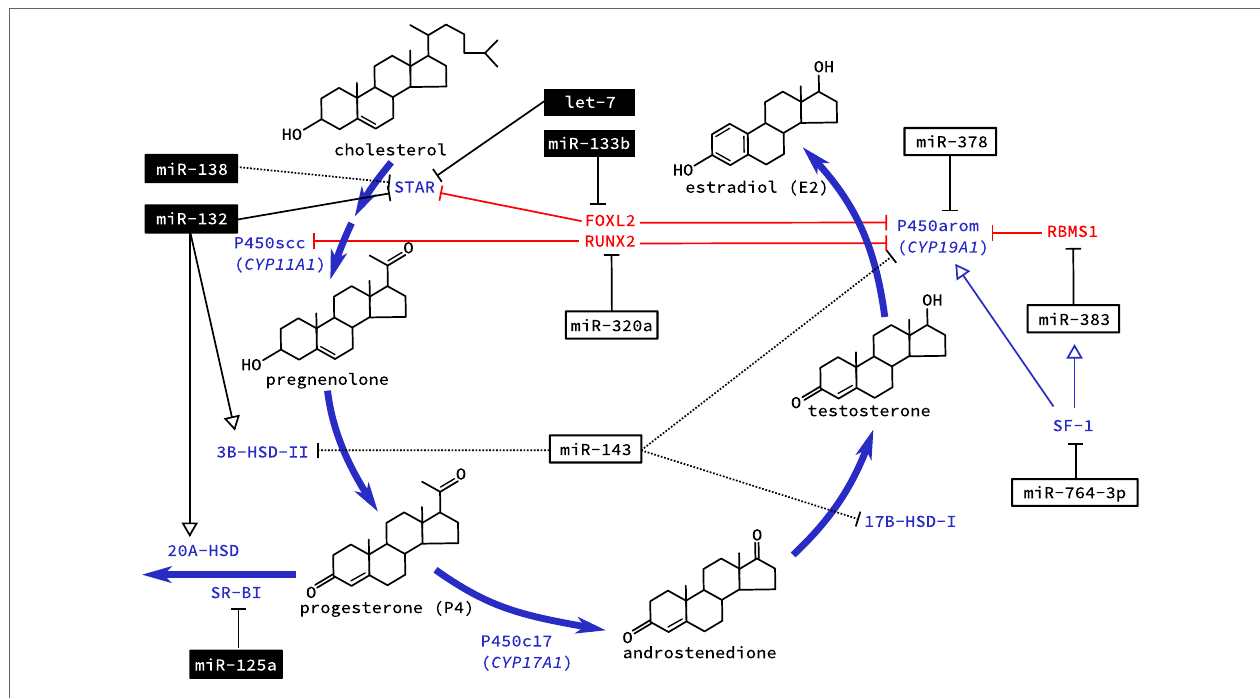
FiGURe 2 | Regulation of steroidogenesis in the ovary by microRNA (miRNA). The two main steroid hormones synthesized in the ovary are estradiol and progesterone. Biosynthesis of these two hormones is regulated in the ovary by miRNA at all levels of regulation including transcription of genes coding for essential enzymes, direct posttranscriptional regulation of these enzymes, and expression of enzymes that catalyze the conversion of these hormones to inactive metabolites. miRNAs that are known to be regulated by cyclic adenosine monophosphate are shown in black boxes; dashed lines indicated an observed effect with unknown mechanism. Note that several metabolic intermediates (e.g., estrone, dehydroepiandrosterone) have been omitted for